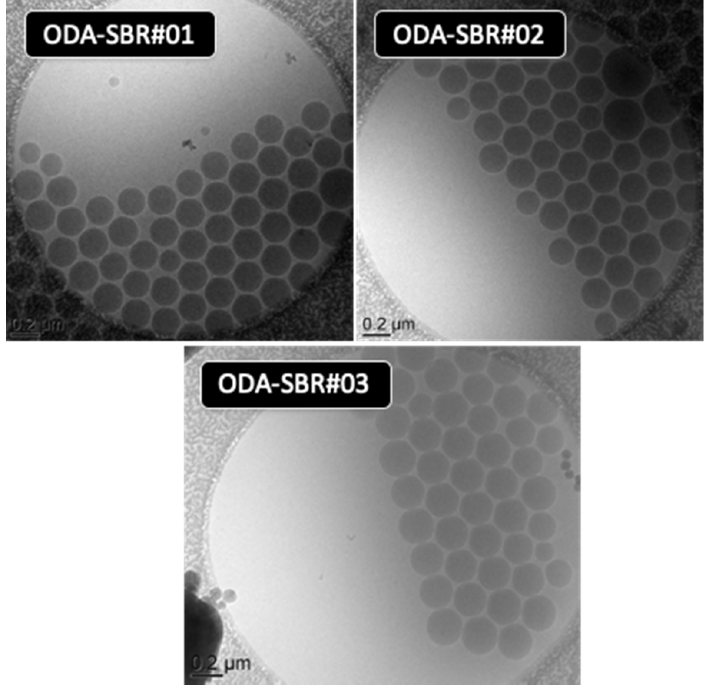
Figure 6. Cryo-TEM images of SBR latexes produced by miniemulsion using ODA as the hydrophobe.